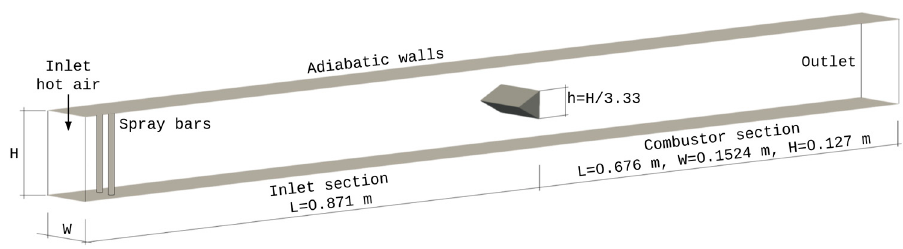
Figure 3. Schematic of the simulation domain used for the AFRL bluff-body combustor.